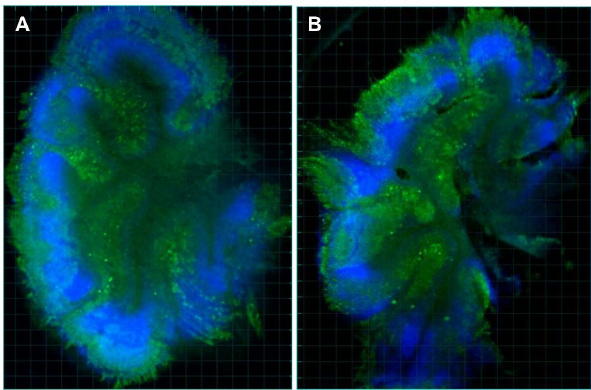
Figure 3. Cerebellar slice architecture after 42 days of culture. Low resolution images (2X) of uninfected (A) and infected (B) cerebellar slices at day 42, demonstrating preserved cerebellar architecture and Purkinje cells. Imaged on an InCell Analyzer. Nuclei are stained with Hoechst (blue) and Purkinje cells are labelled with Calbindin/ Alexafluor488